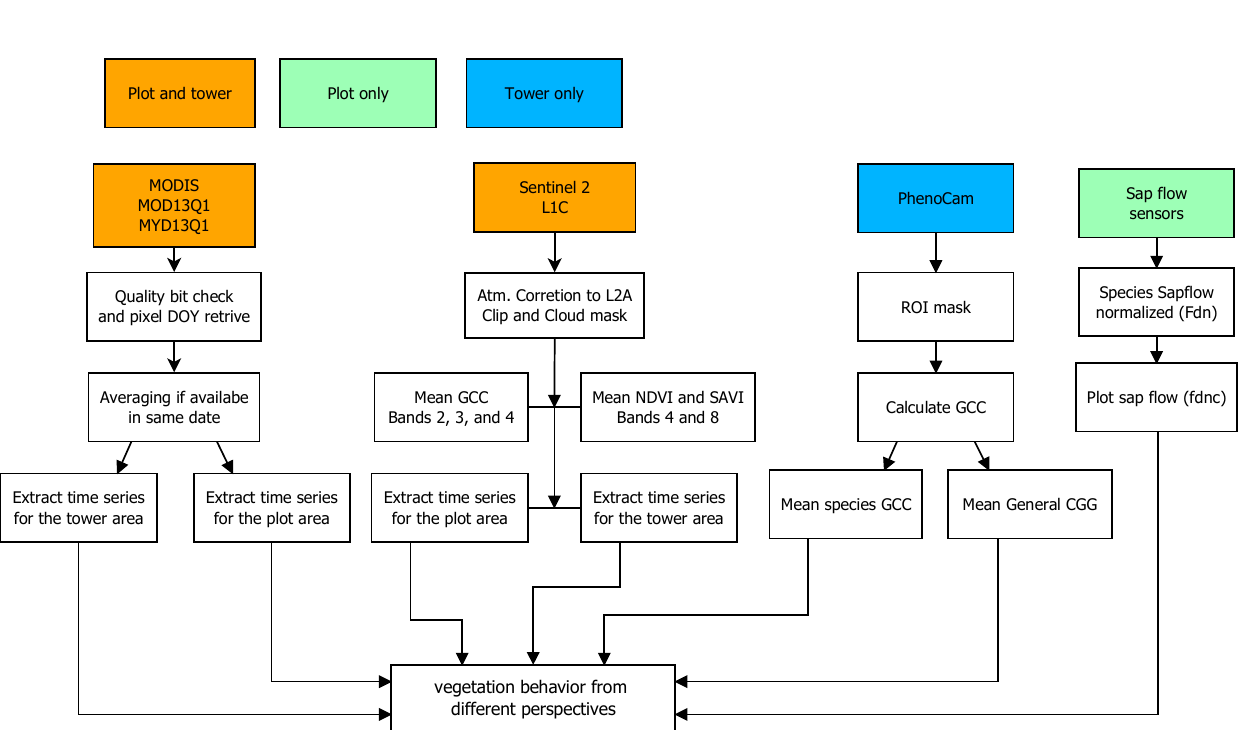
Figure 2. Flowchart of the experimental design.